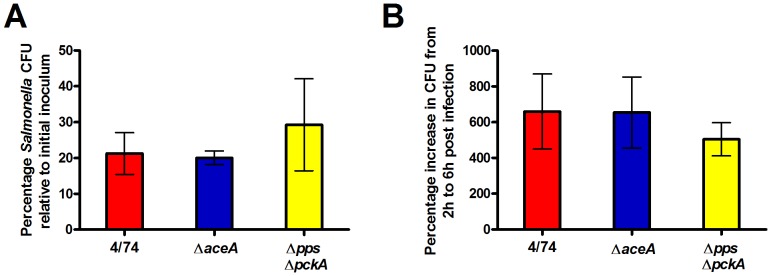

S. Typhimurium does not require the glyoxylate shunt or gluconeogenesis for intracellular replication within HeLa cells.Invasion (A) and intracellular replication (B) of S. Typhimurium 4/74, ΔaceA (JH3385), and ΔppsΔpckA (JH3487) strains during infection of HeLa cells. (A) The chart shows the numbers of viable bacteria (expressed as percentages of the initial inoculum) within host cells at 2 h after infection. (B) The chart shows the percentage replication of bacteria between 2 h and 6 h. Each bar represents the statistical mean from two biological replicates (performed in triplicate) and the error bars represent the standard deviation.